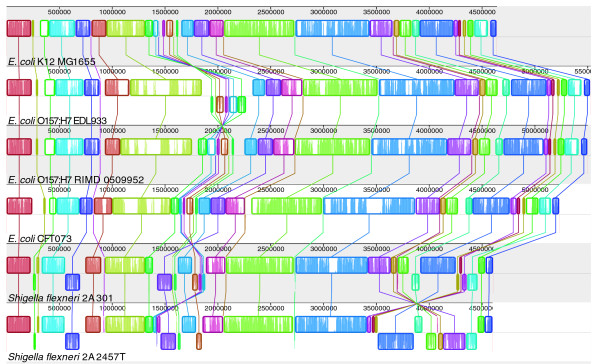
A multiple whole-genome alignment of six strains consists of 34 rearranged pieces larger than 1 kb. Each genome is laid out horizontally with homologous segments (LCBs) outlined as colored rectangles. Regions inverted relative to E. coli K-12 are set below those that match in the forward orientation. Lines collate aligned segments between genomes. Average sequence similarities within an LCB, measured in sliding windows, are proportional to the heights of interior colored bars. Large sections of white within blocks and gaps between blocks indicate lineage specific sequence.